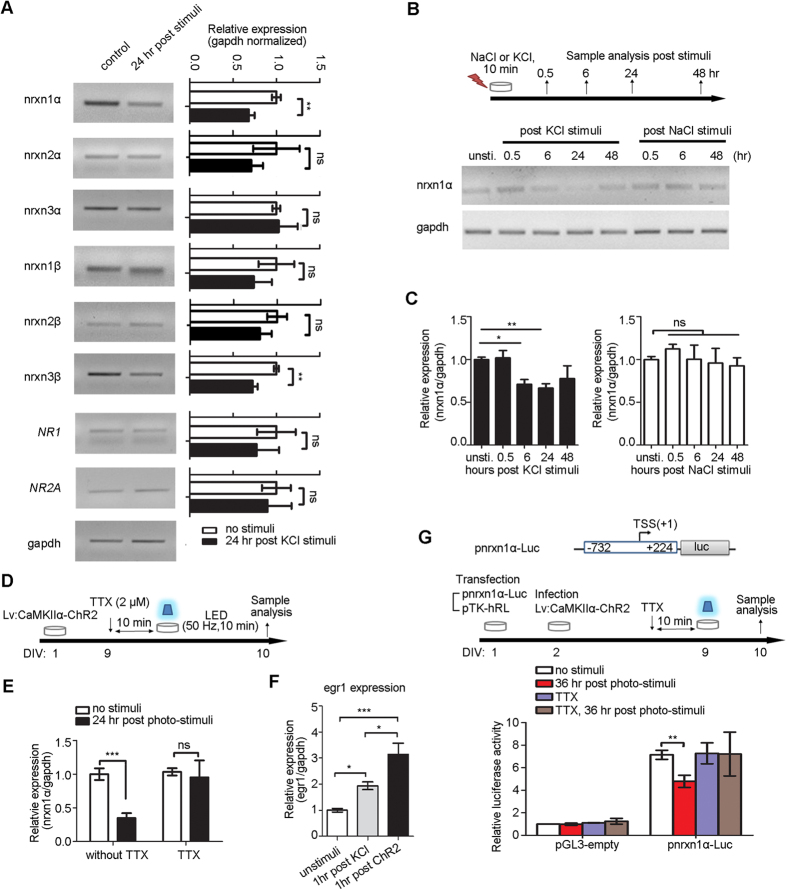
Activity-dependent repression of nrxn1α in primary cortical neuron cultures.(A) RT-PCR analysis of nrxns and other gene transcripts in primary cortical neuron cultures 24 hours after stimulation by a high K+ concentration (51 mM, 10 min) (left panel). Real-time qPCR analysis revealed a decrease in nrxn1α and nrxn3β mRNA after high K+ stimulation (full-length gels in Fig. S1; n = 4 biological samples; Student’s t-test, **P < 0.01, ns, no significance). (B,C) Primary cortical neuron cultures were subjected to transient stimulation by KCl or NaCl on DIV9 (B) (full-length gels in Fig. S1). The nrxn1α expression was analyzed using RT-PCR after stimulation (C) (n = 13 biological samples for KCl stimulation; n = 3 biological samples for NaCl stimulation; One-way ANOVA followed by Dunnett’s post hoc test, *P < 0.05, **P < 0.01, ns, no significance). (D,E) Primary cortical neuron cultures were infected by lenti-virus LV: CamKIIα-ChR2-EGFP at DIV 1 and stimulated with LED (50 Hz, 5 ms/pulse, 10 min). Expression of nrxn1α was quantified using qPCR (n = 9 for normal group, n = 3 for TTX treatment group; two -way ANOVA followed by a Bonferroni post hoc test, ***P < 0.001, ns, no significance). (F) Levels of egr1 expression induced by KCl stimuli (grey) or optical stimuli (black) (n = 8 for control group, n = 5 for KCl stimuli group, n = 5 for light stimuli group; *P < 0.05, one -way ANOVA followed by Tukey’s post hoc test, *P < 0.05, ***P < 0.001). (G) Luciferase assay revealed activity-dependent repression of nrxn1α promoter activity. The nrxn1α promoter is cloned to drive the expression of firefly luciferase in pGL3-enhancer. pTK-renilla luciferase was co-transfected as the control. Luciferase activity was measured 36 hours after optogenetic stimulation. The ratio of Firefly/Renilla luciferase activity was reported (n = 6 for normal group, n = 3 for TTX treatment group; two-way ANOVA with Bonferroni post hoc test, **P < 0.01).